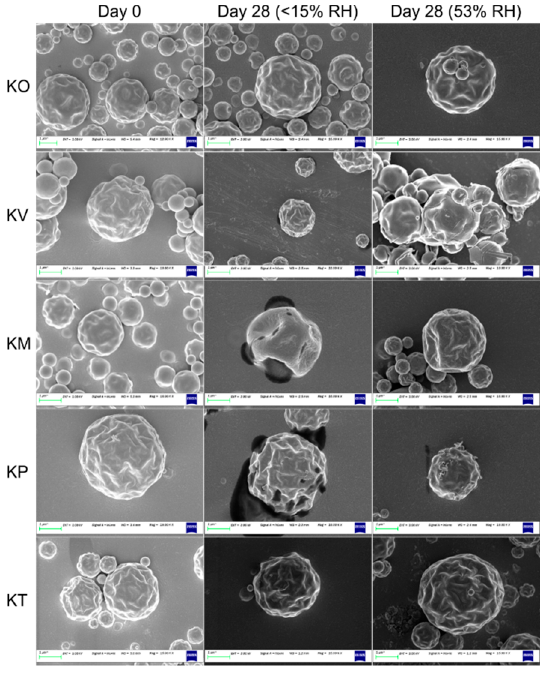
Figure 4. Representative SEM images of the formulations (kanamycin only (KO), kanamycin-valine (KV), kanamycin-methionine (KM), kanamycin-phenylalanine (KP), and kanamycin-tryptophan (KT)) on day 0 and day 28 when stored at 25 °C/<15% RH and 25 ° C/53% RH.